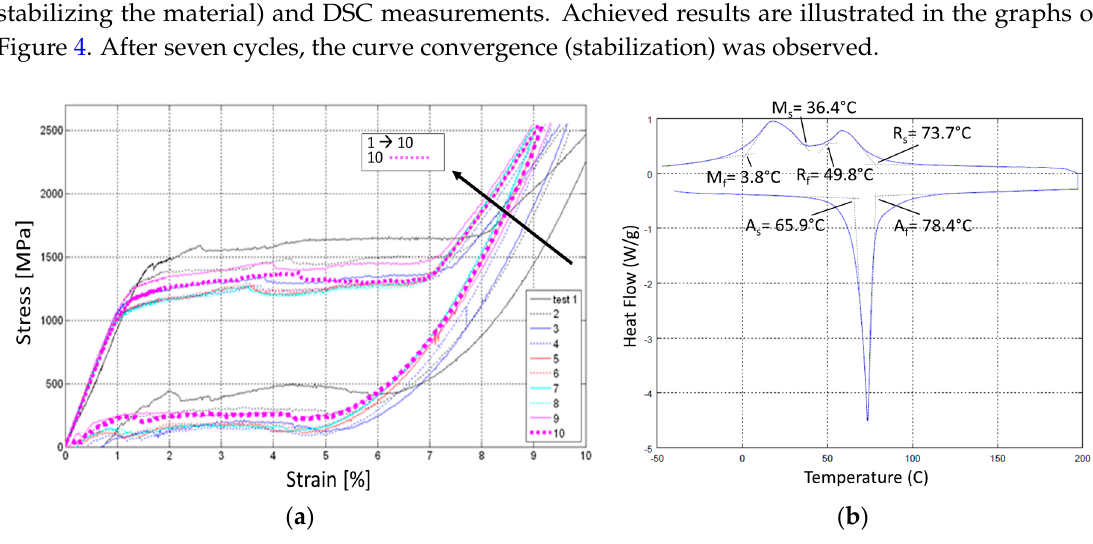
Figure 4. Experimental characterization of the spring material: tensile cycles ( a ); DSC measurements ( b ). In the figure, 10 cycles are reported. They show an oscillating behavior, convergent towards the dotted line.